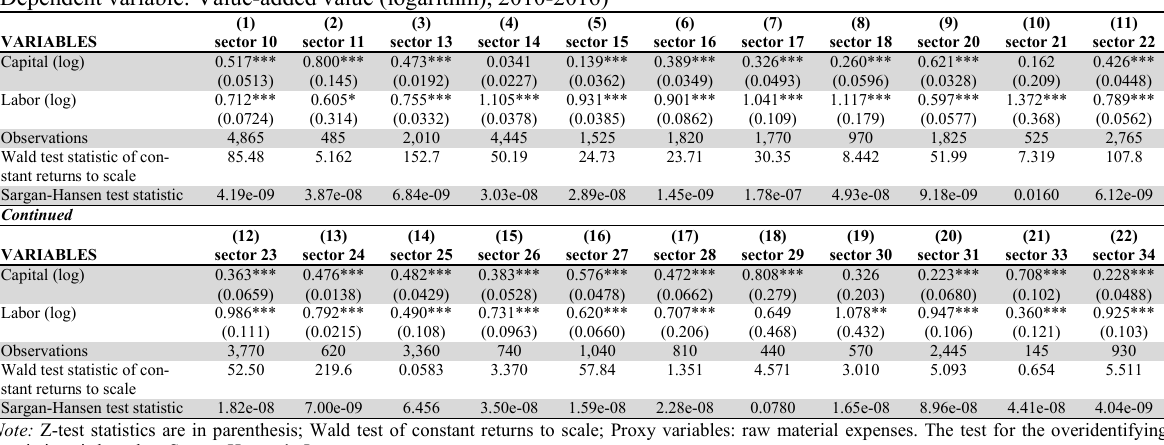
Cobb-Douglas production function estimation using D. A. Ackerberg et al. (2015) estimator (Dependent variable: Value-added value (logarithm), 2010-2016) (1)